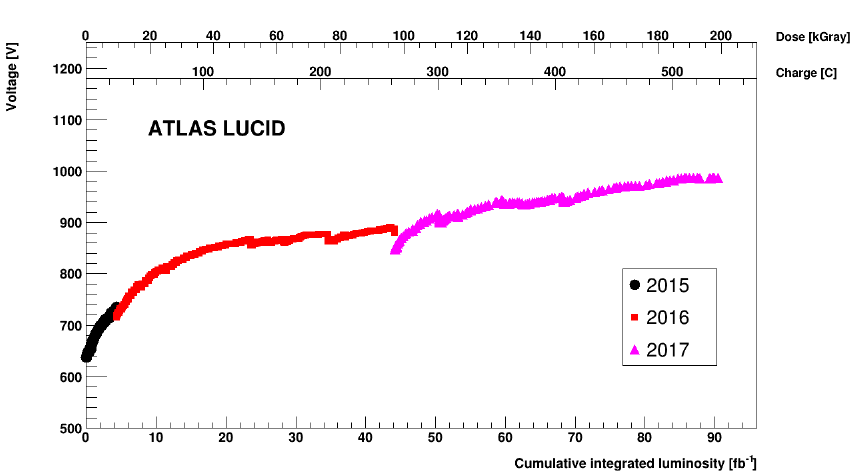
Figure 2. Average high voltage (HV) applied to four PMTs as a function of cumulative luminosity delivered by the LHC from 2015 to 2017 [5]. The maximum HV the PMTs can sustain is 1250